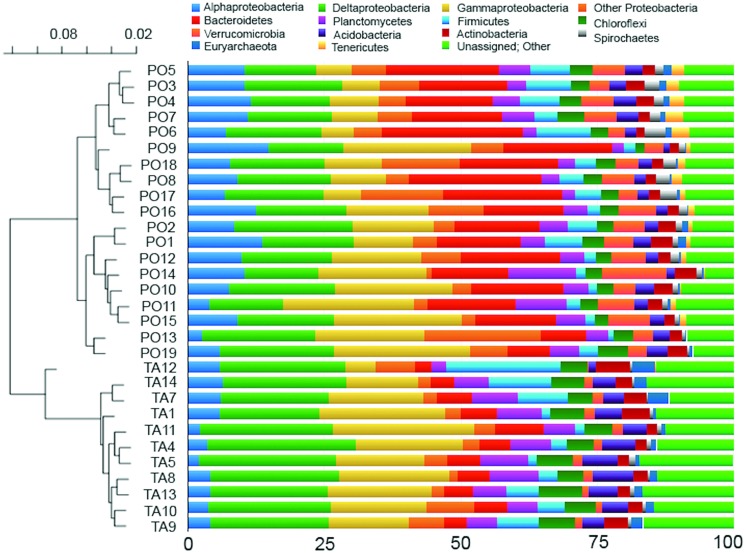
Community composition and Unweighted Pair Group Method with Arithmetic mean (UPGMA) dendrogram. Combined panel showing the relative abundance of prokaryotic phyla, or classes (for Proteobacteria), in the sampled stations (Right) and the UPGMA dendrogram, based on unweighted Unifrac distances matrix (Left). On the right panel, phyla or classes showing a mean relative abundance across all stations <1%, as well as all the unassigned sequences, were aggregated into the group reported as “Unassigned; Other.”